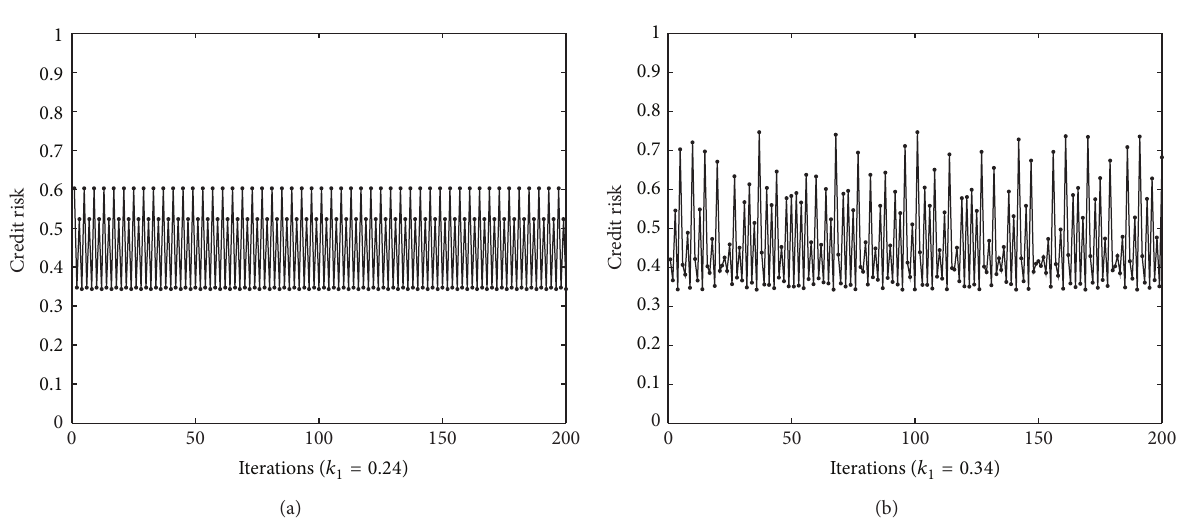
Figure 4: Chaotic attractors of the dynamic system.